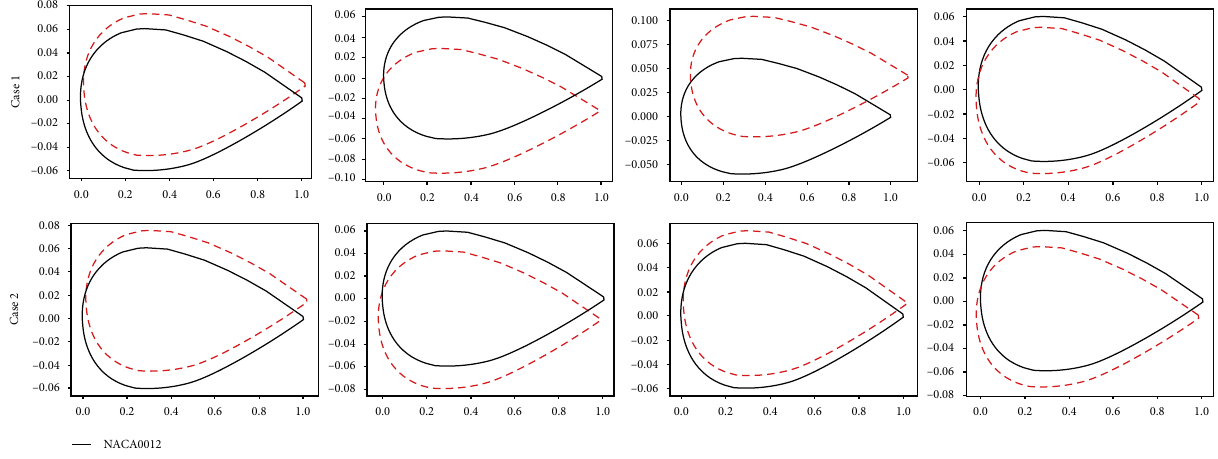
Figure 9: NACA 0012 airfoil and its adjustments after enlarging the output of the speci fi c neuron in the fi rst convolutional layer. Di ff erent columns show the results in di ff erent